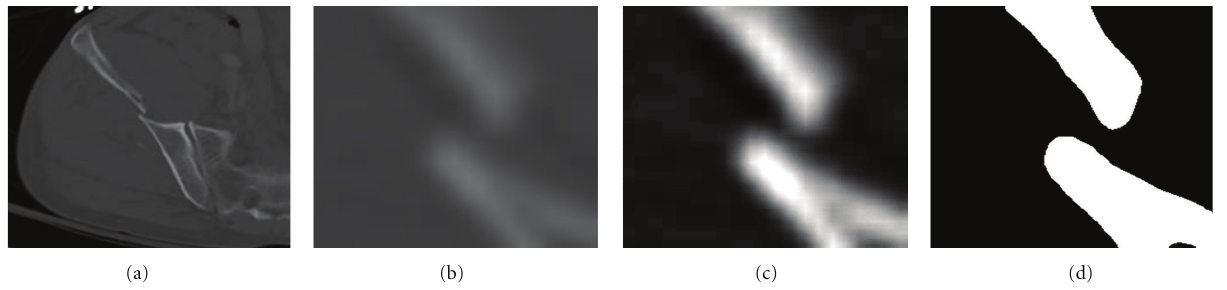
Figure 8: Example of a detected broken boundary of pelvic bone, which may indicate a